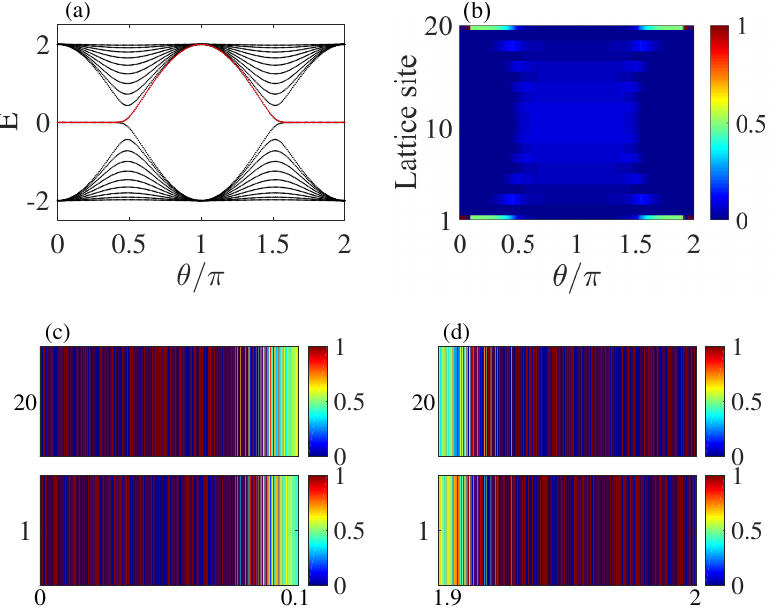
Figure 2. The energy spectrum and the distribution of the zero energy mode. ( a ) The energy spectrum of the even-sized Su–Schrieffer–Heeger (SSH) model. The red line represents the ( N + 1 ) th eigenvalue versus the periodic parameter θ . ( b ) The eigenstate of the selected zero energy mode (red line in ( a )) versus θ and lattice site. The detailed distributions of the selected zero energy mode at the two-end resonators are shown in ( c ) with θ ∈ [ 0, 0.1 π ] and in ( d ) with θ ∈ [ 1.9 π , 2 π ] . The size of the lattice is = − g 2 = 2 N with N = 10. In the unit of − g 2 2 1